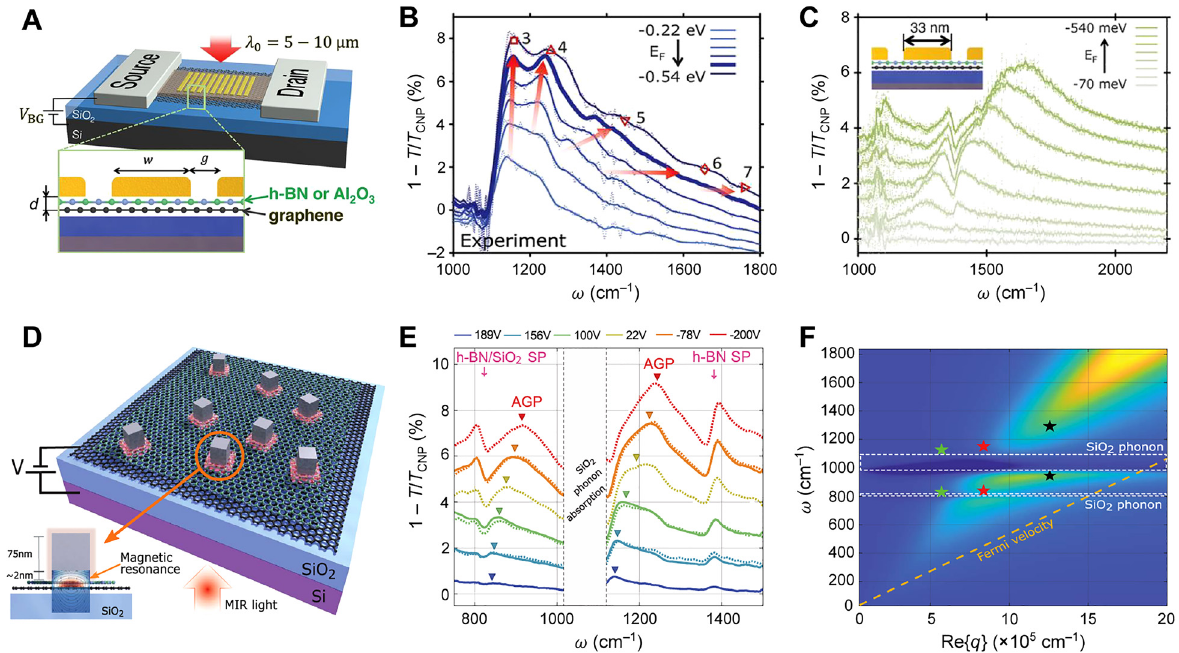
Figure 5: Far-field probing of IGPs. (A) Schematics of the device enabling FTIR spectroscopic detection of IGPs coupled to free-space light via an array of gold